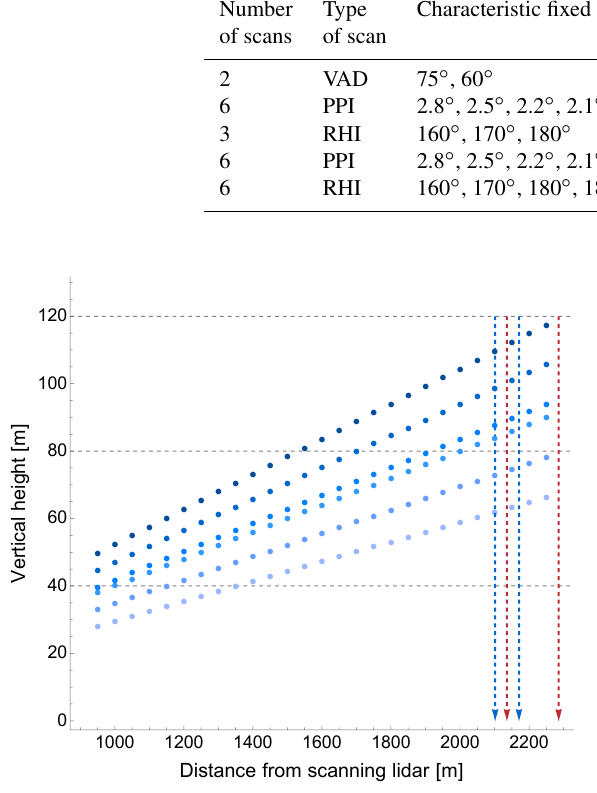
Table 2. Description of the 30min cycle of scanning lidar scans in CWEX-13 field campaign. The characteristic fixed angle refers to the elevation angle for PPI and VAD scans and the azimuth angle for RHI scans. Number Type Characteristic fixed angle Duration of Cumulative of scans of scan each scan time 2 VAD 75 ◦ , 60 ◦ 132s 00:00–04:24 04:24–14:48